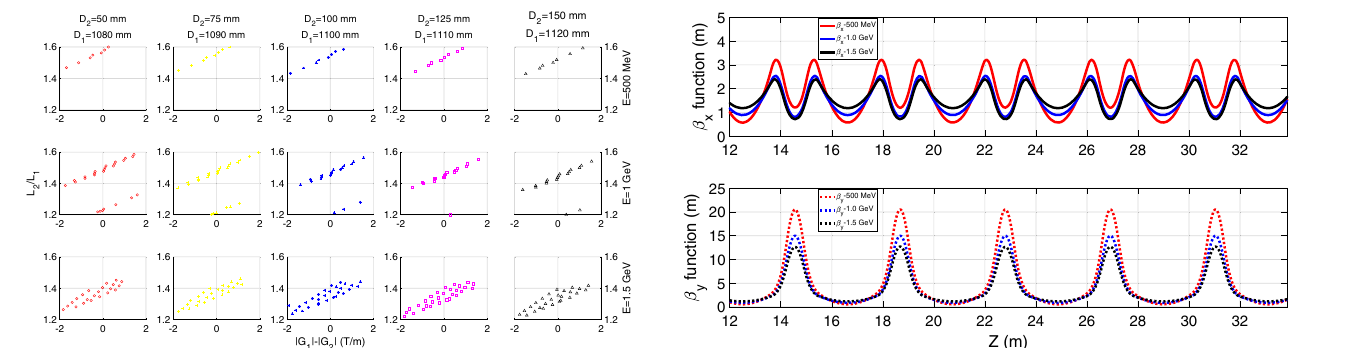
FIG. 7. β function in VDS. (Beam sizes are the same at vacuum holes for different energies. Since the geometric emittance for lower energy beam is larger, β function at the waist is smaller).